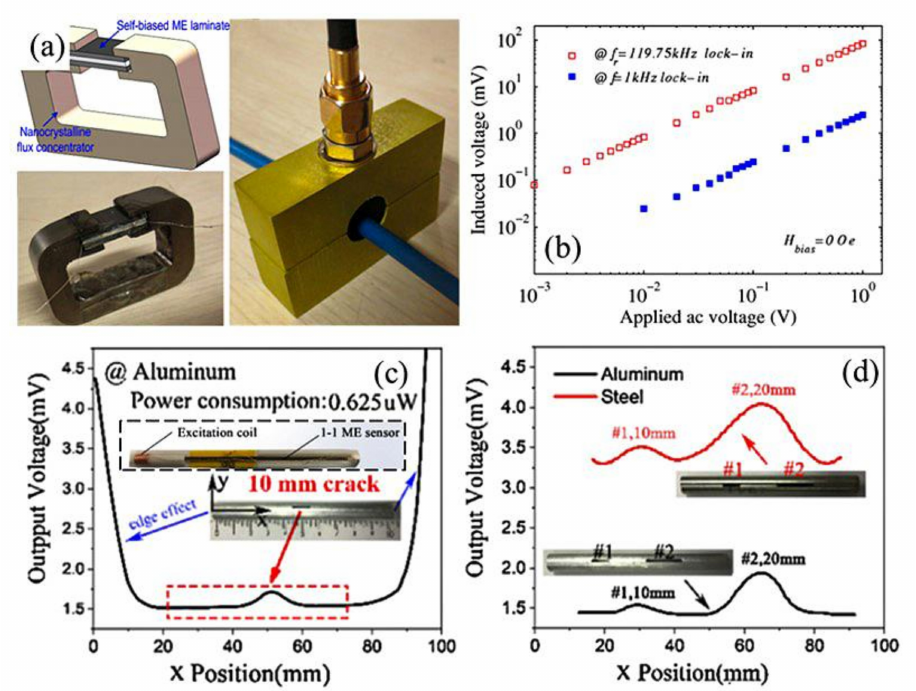
Figure 12. ( a ) Schematic and photograph of the current-sensing device; ( b ) Comparison of the sensitivities measured at low frequency and resonant frequency [78]. ( c ) Measured ME voltage response with respect to an aluminum pipe with a 10 mm crack in the center (the inset highlighted by dashed line showed the structure of the ME ECT probe). ( d ) Crack identifying results for one-dimensionally distributed cracks labelled 1# and 2# for an aluminum pipeline and steel pipeline, respectively